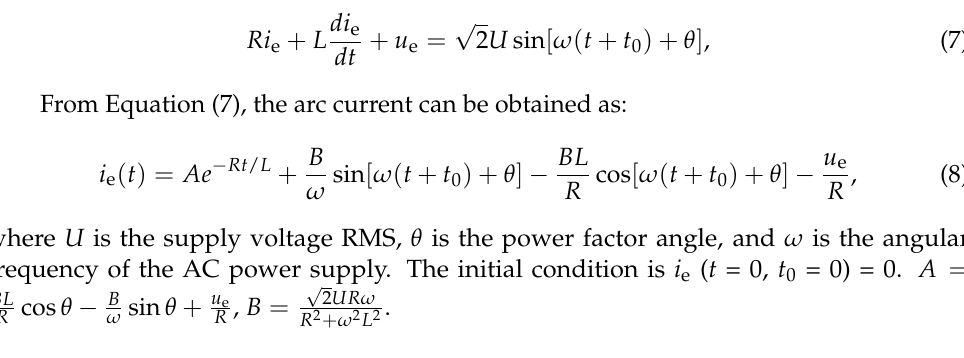
Figure 3. Equivalent circuit diagram of the contact breaking load circuit. After the contacts of the LVCB are separated, an arc is generated between the contacts. The existence of the arc changes the original structure of the circuit. For the LVCB, on the one hand, the existence of the arc voltage plays a role in limiting the current, and on the other hand, the factors affecting the electrical life become more complicated. According to Figure 3, the voltage equilibrium equation is as follows: